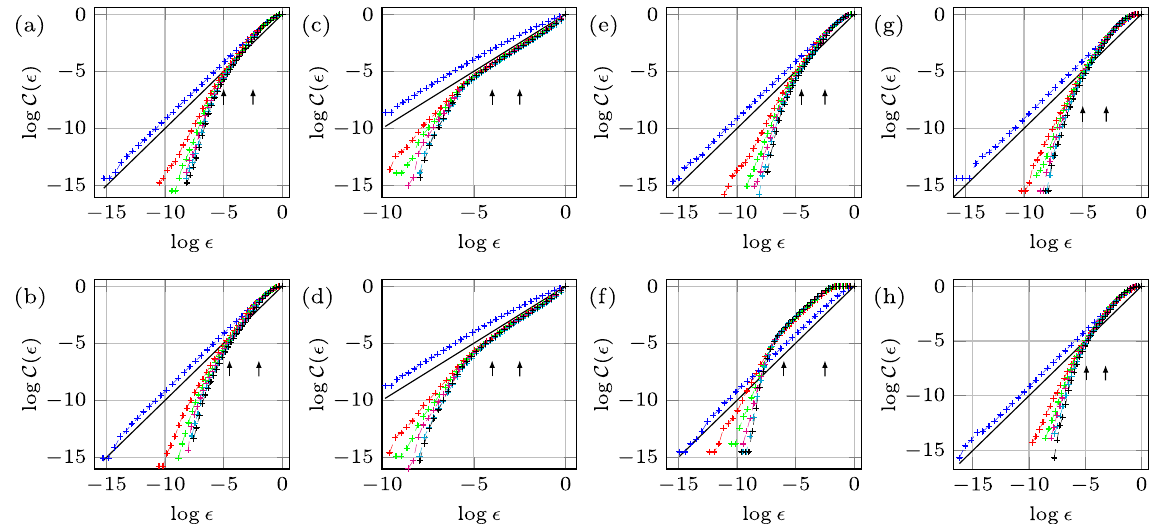
Figure 3. The correlation function C (ǫ) obtained for each physical experiment from a single time series of the real part of the slow amplitude Re U for various embedding dimensions m . The solid black line with slope one is shown to compare with the saturated slope D in the scaling region (between the two arrows). Panels ( a , b ), ( e , f ), and ( g , h ) indicate the chaotic strange attractor dimension D = 1.38 , 1.42, 1.52, 1.00, 1.48, and 1.31 ± 0.02 , corresponding to Figs. 2a,d, 4a,d, and 5a,d, respectively. In ( c ) the correlation function for 100 fast cycles prior to wall motion in Fig. 2d is presented indicating regular periodic dynamics with D = 1.00 ± 0.02 , whereas in ( d ) inclusion of 65 additional fast cycles corresponding to the interval of domain shrinkage δ L = 1.3mm resulted in the fractal dimension D = 1.1 ± 0.02 indicating the transition into in the envelope ( 36.1% ), thus indicating the amplitude chaos with no phase-slips. Third , in this case the transi- tion from chaotic to periodic state takes place during the wall motion (indicated by arrows) over δ L = 1.68mm , which is smaller than the total domain size variation (cid:31) L = 2 mm ; that is, the amplitude a ( t , τ) reaches constant envelope over δ L , and once the wall motion ceases at (cid:31) L the system is already oscillating periodically with a time-independent envelope. However, this scenario is not universal: in other experiments, e.g. in Fig. 11a with an initial chaotic state of dimension D = 1.82 undergoing domain growth at a rate 0.15mm s − 1 , the transition